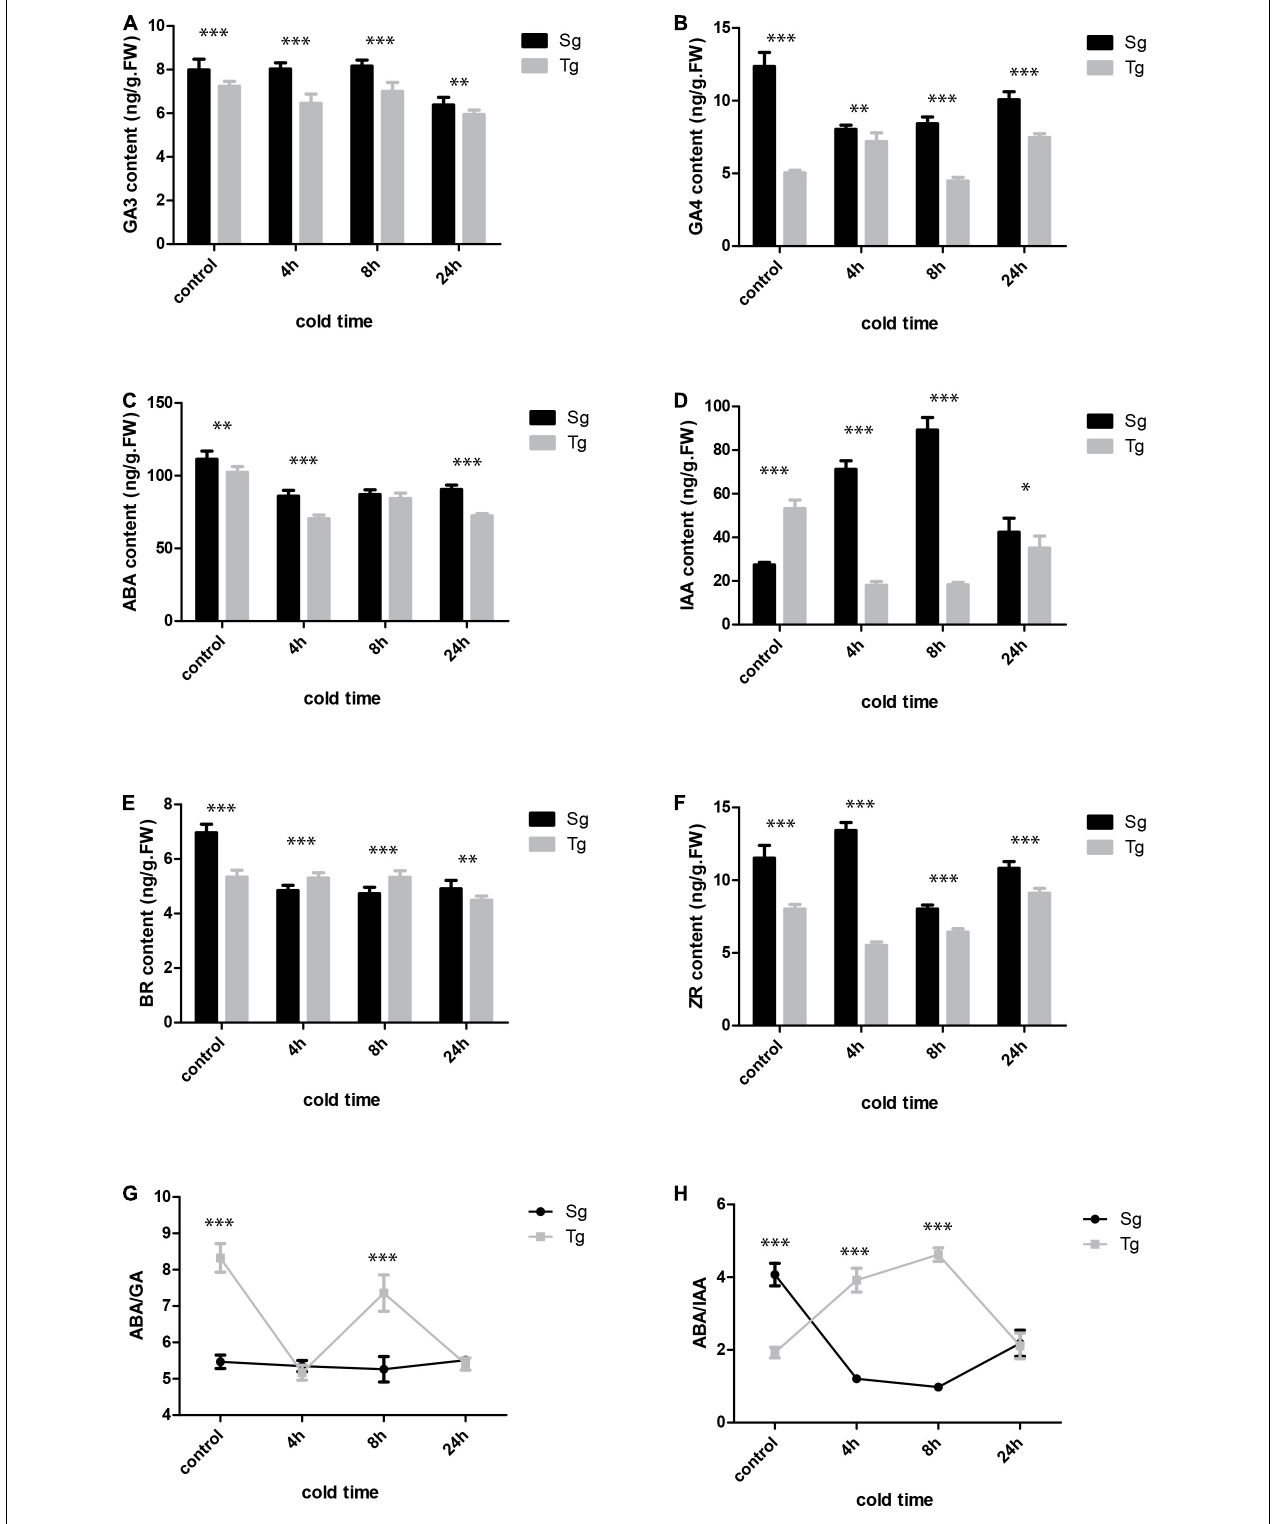
FIGURE 6 | The hormone levels in the two C. japonica populations at 0, 4, 8, and 24 h of cold treatment time. (A) GA3. (B) GA4. (C) ABA. (D) IAA. (E) BR. (F) ZR. (G) ABA/GA ratio. (H) ABA/IAA ratio. Data are mean ± standard deviation (SD) (three biological replicates and three technical repeats), ∗ symbol indicates significant difference between the two groups was determined by Student’s t -test ( ∗ P < 0.05, ∗∗ P < 0.01 or ∗∗∗ P < 0.001).